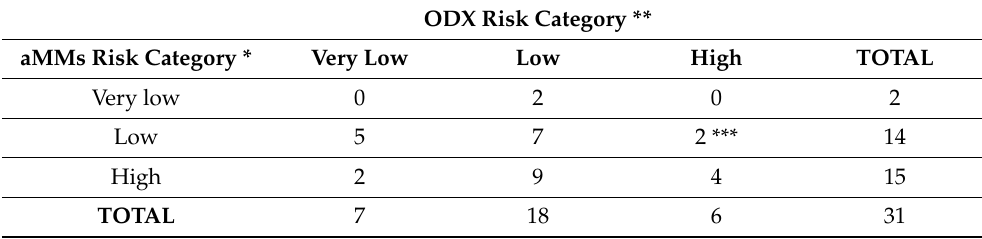
Table 3. Recurrences and associated risk categories.